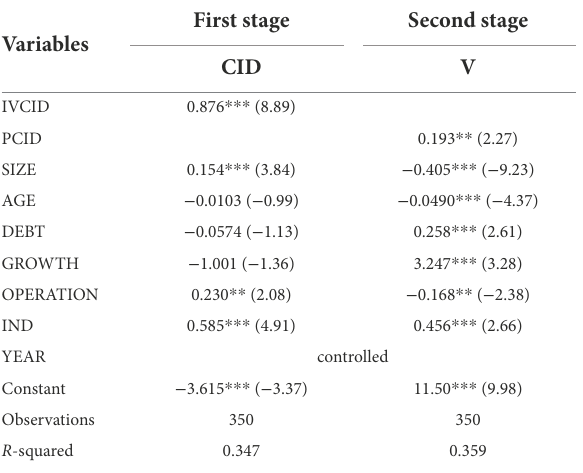
TABLE 13 Endogeneity tests.